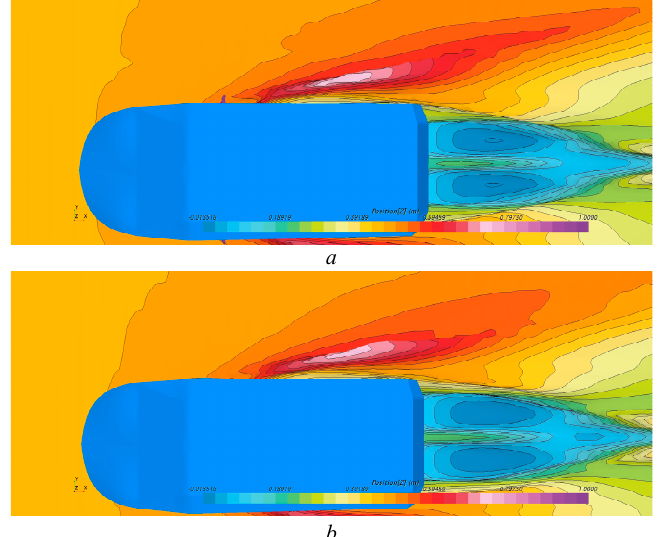
Figure 17. Wake flow on both sides of HSAV with or without Flanks in planing condition (( a ) origin, ( b ) Flanks).